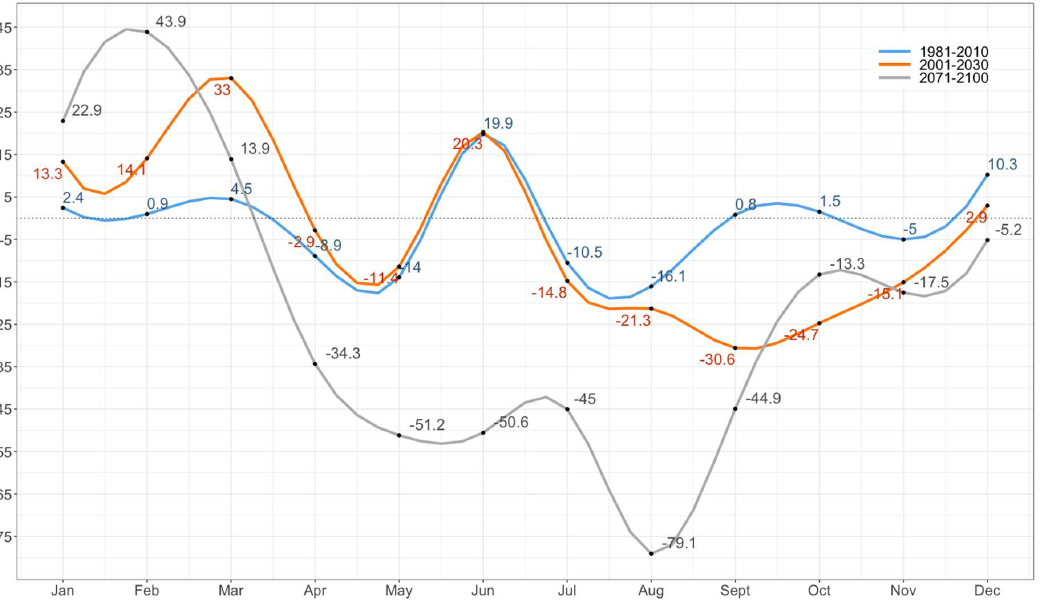
Figure 2. The relative deviation (%) of average annual precipitation for current (1981–2010) and future